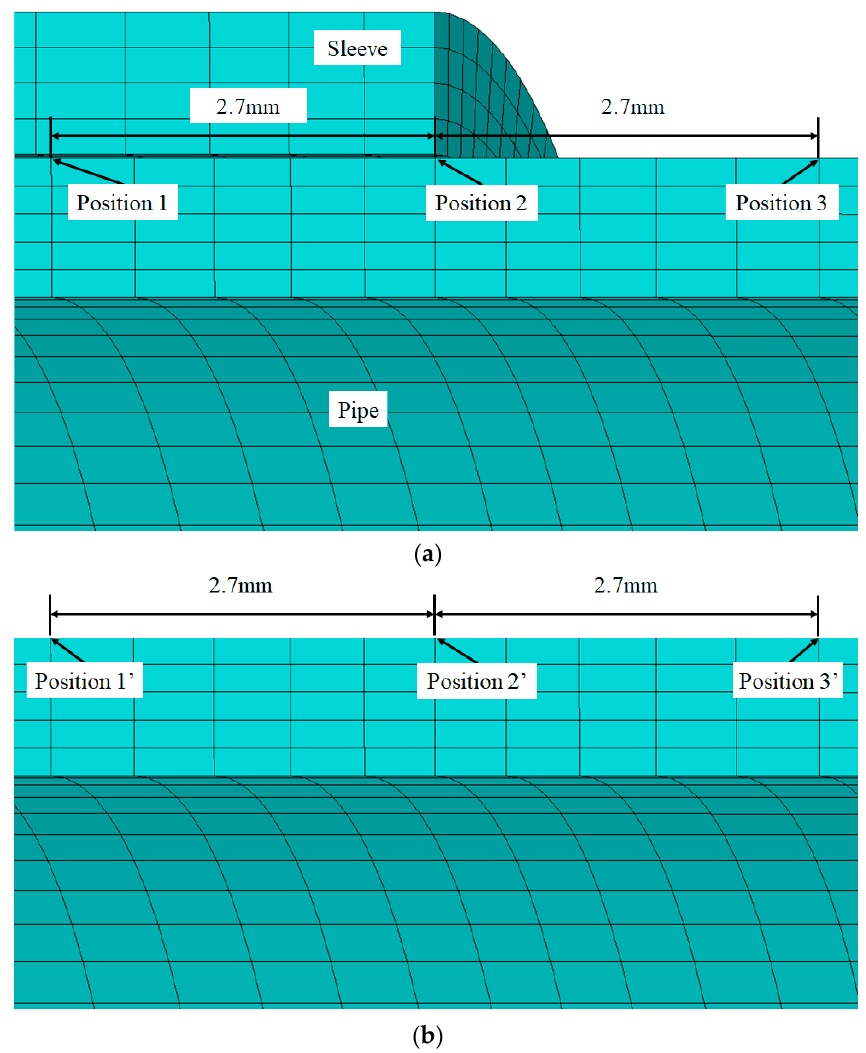
Figure 5. The area marked in Figure 3 with the wireframe: ( a ) Pipe with assembly parts and ( b ) pipe without assembly parts.